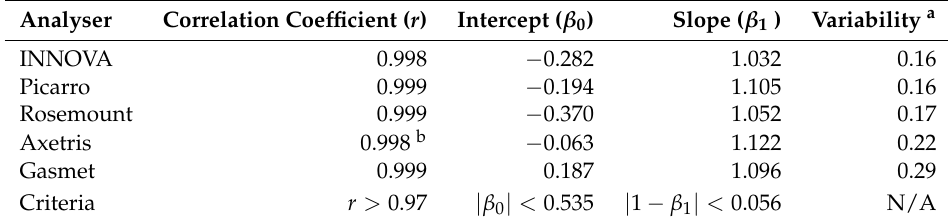
Table 3. Compliance of equivalence between the wet-chemistry method and five gas analysers on measuring ammonia (NH 3 ) concentrations in air. The assessment criteria on the correlation coefficients, intercept, and slope are determined according to EN 14793